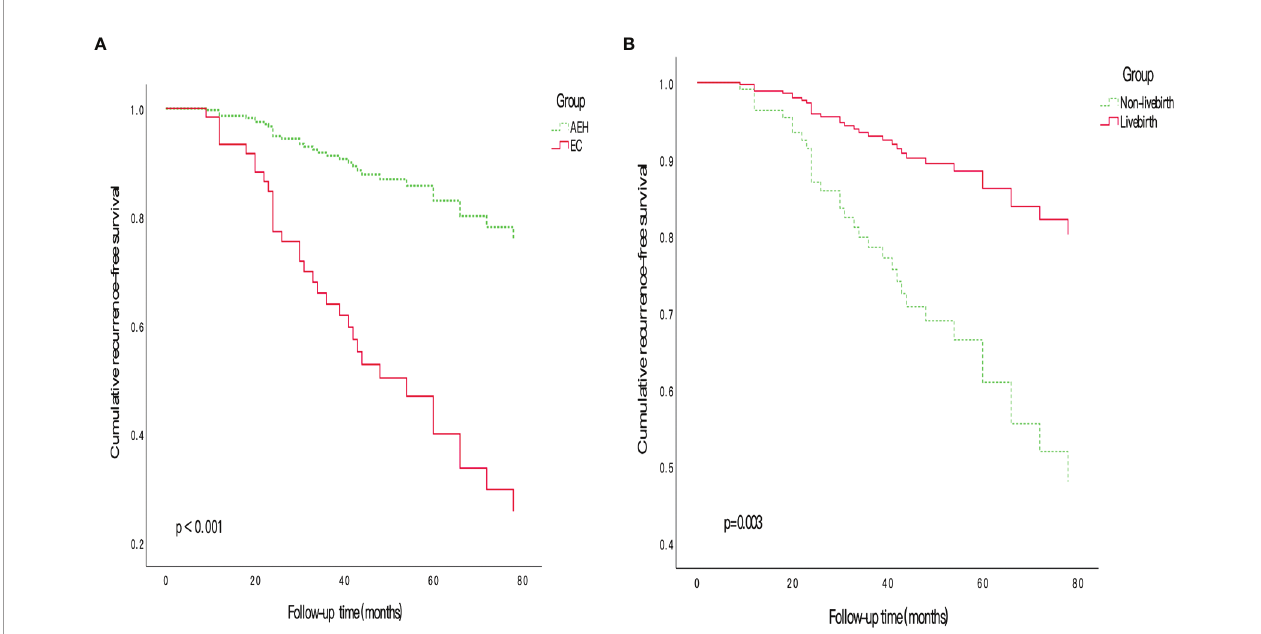
FIGURE 2 | Cumulative RFS curves in fertility-sparing EEC/AEH patients after ART (A) The cumulative RFS in patients of AEH group and EC group. Patients had longer RFS with histology of AEH than patients with EC. (B) The cumulative RFS in patients of livebirth group and non-livebirth group. The cumulative RFS in patients who got a child successfully was longer than patients failed to get a child. AEH, atypical endometrial hyperplasia; ART, assisted reproductive technology; EEC, early stage endometrial cancer; RFS, recurrence-free survival.